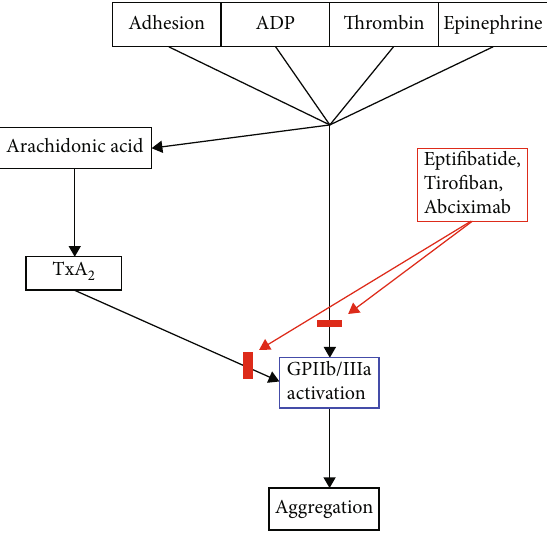
Figure 2: Flow chart demonstrating platelet activation via GP IIb/IIIa activation. Epti fi batide and similar drugs (red) inhibit the aggregation pathway by blocking GP IIb/IIIa functionality.